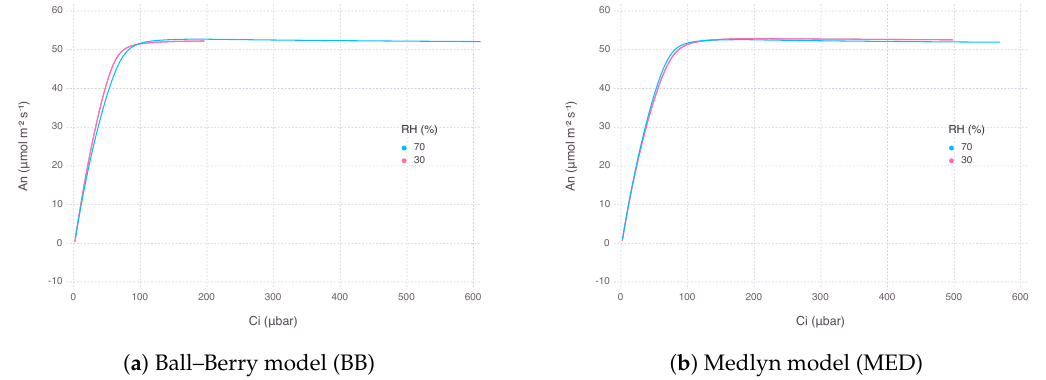
Figure 3. Net photosynthesis rate ( A n ) estimated by two stomatal conductance models over a range of atmospheric CO 2 concentration ( C a ) from 10µbar to 1500µbar at two levels of relative humidity (RH). The graph was plotted against resultant intercellular CO 2 concentration ( C i ). Air temperature ( T a ) was 32 ◦ C and irradiance ( I ) was 2000µmol quanta m − 2 s − 1